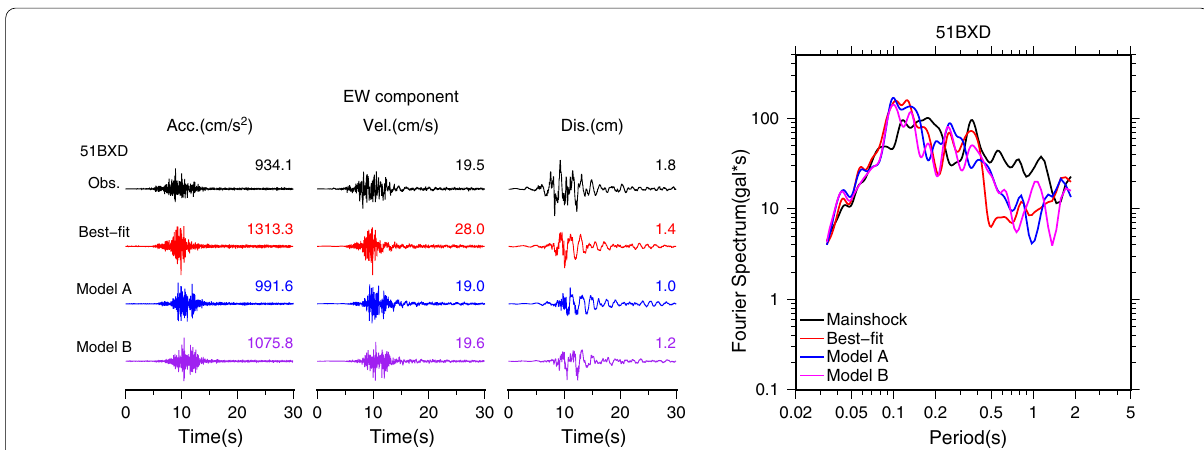
Fig. 10 Waveforms and acceleration Fourier spectra between the observed and synthesized ground motions in the EW component at Station 51BXD during the mainshock. Observed and synthesized waveforms (acceleration, velocity and displacement) are shown in the left panel. Black lines represent the waveforms of the observed ground motions. Red, blue, and purple lines represent the waveforms of the synthesized ground motions for the best-fit model, Model A and Model B, respectively. Acceleration Fourier spectra of the observed ground motions and the synthesized ground motions of three models are shown in the right panel. The Fourier spectra are smoothed by use of a logarithmic window function (Konno and Omachi